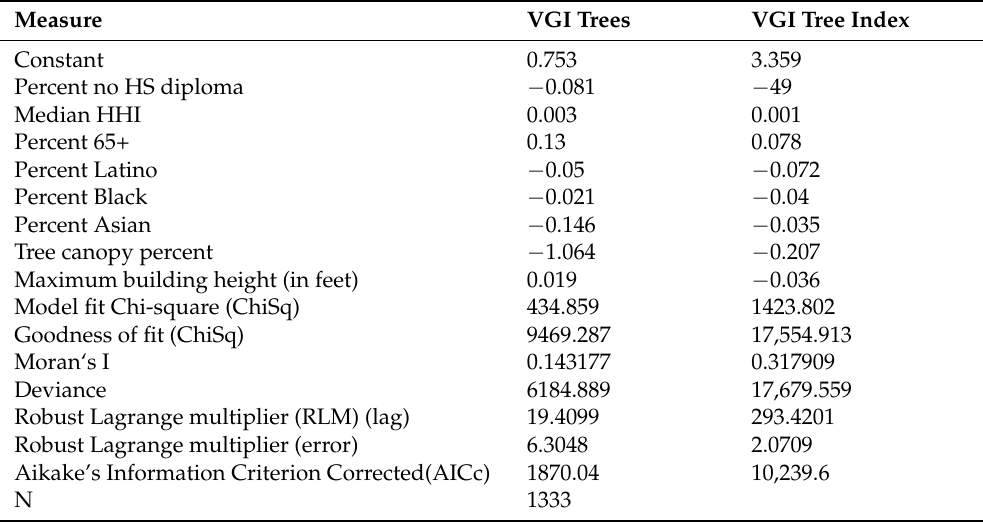
Table 3. Philadelphia analytical